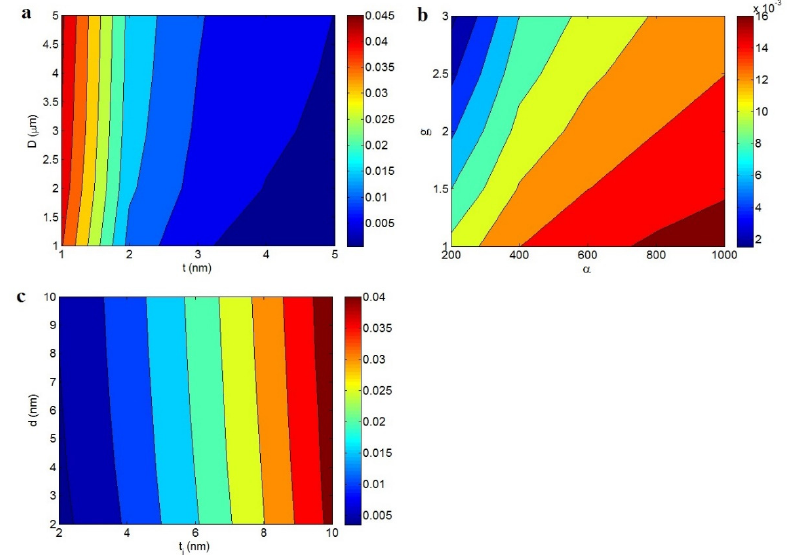
Figure 2. Altered points of ( a ) t and D , ( b ) α and g , and ( c ) t i and d assuming the interphase part, tunneling size, and filler agglomeration according to Equation